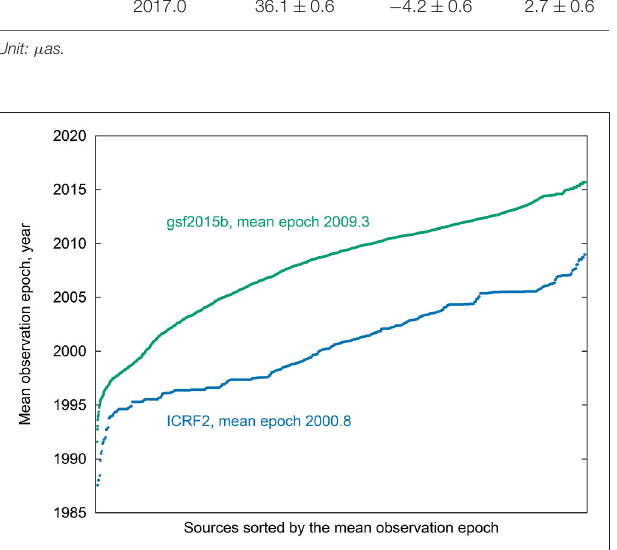
FIGURE 10 | Source observations epoch for the ICRF2 and gsf2015b